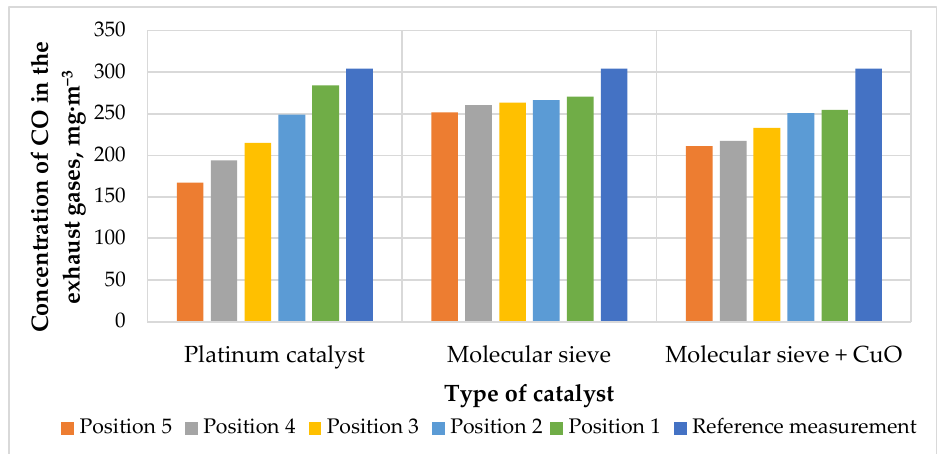
Figure 6. CO concentration in exhaust gases depending on the type and location of the catalyst.